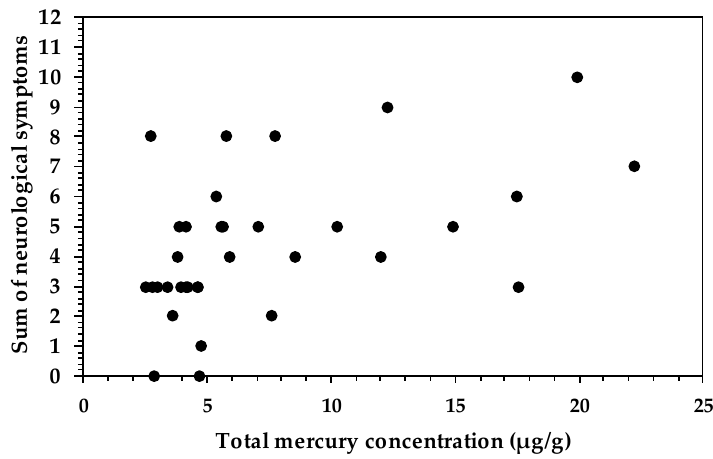
Figure 6. Relationships between total mercury concentration and the sum of neurological symptoms.